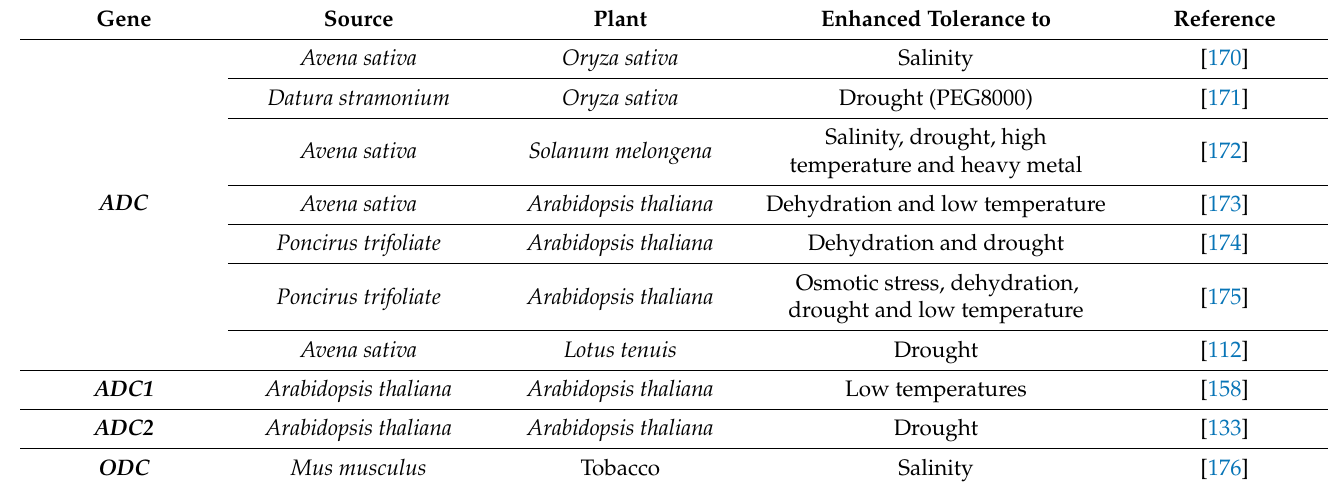
Table 1. ADC and ODC transgenic plants showed enhanced tolerance to different abiotic